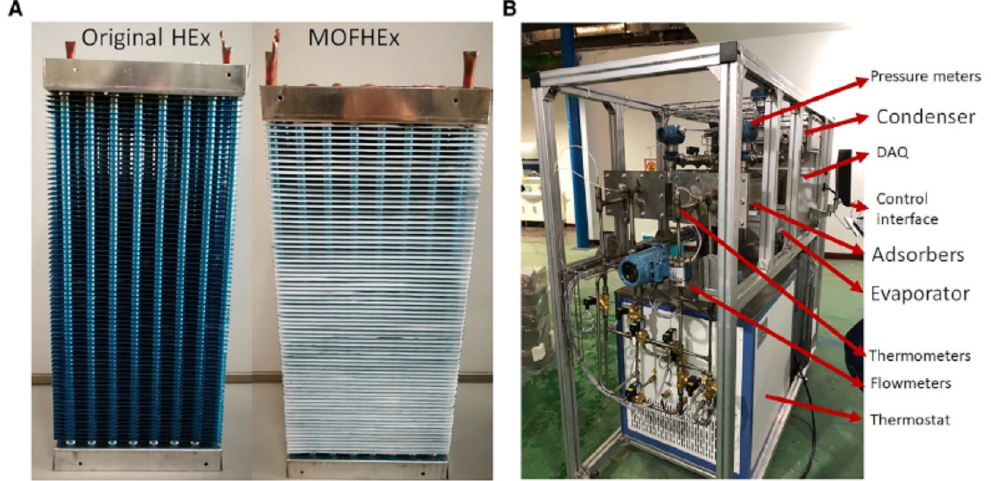
Figure 10. ( a ) Images of original and coated Hex; ( b ) View of the adsorption chiller test unit. Reprinted/adapted with permission from Ref. [37]. (Copyright 2021), Elsevier.